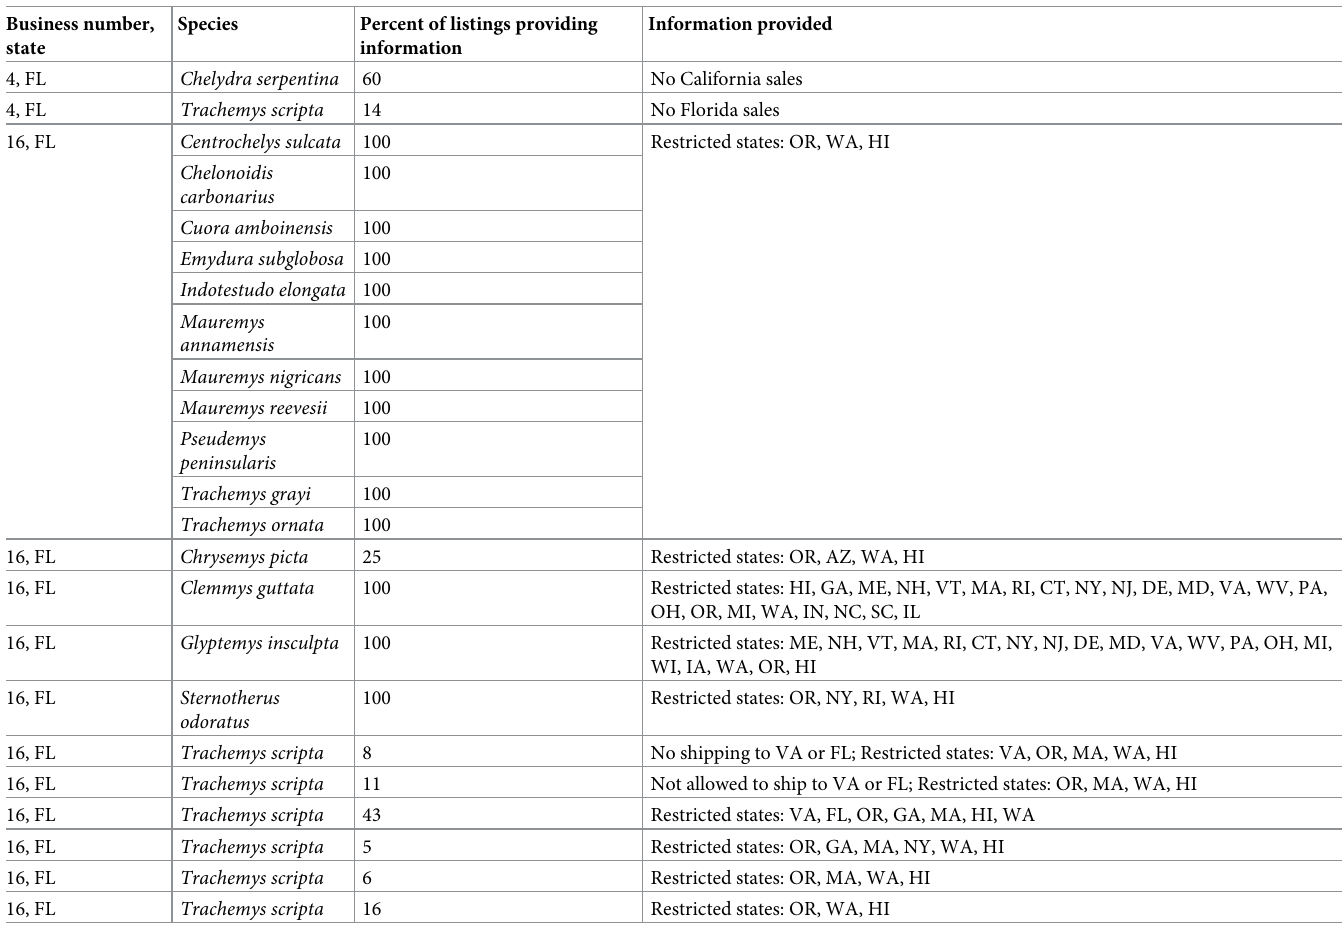
Table 2. Information provided on two websites regarding restricted sales or shipping to particular states for turtles < 4 inches in size. Information provided for busi- ness number 16 (Florida) for sliders ( Trachemys scripta , all subspecies combined) changed among listings and over the course of our surveys; all information that appeared related to T . scripta for business number 16 during our surveys is provided